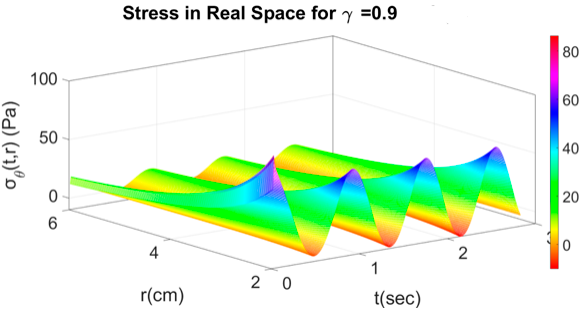
Figure 4. Distribution of the radial stress 𝜎 (cid:3045) (𝑡, 𝑟) in the initial space for γ = 0.9. Further, Figure 5 shows the stress 𝜎 (cid:3087) (𝑡, 𝑟) in the initial space for γ = 0.9.